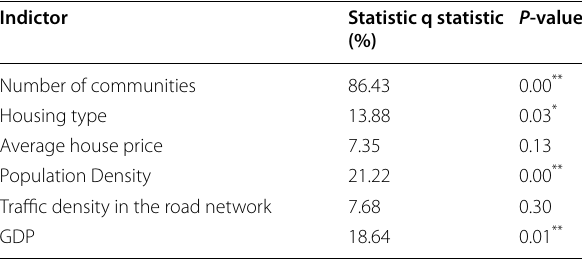
Table 2 Results of factor detector